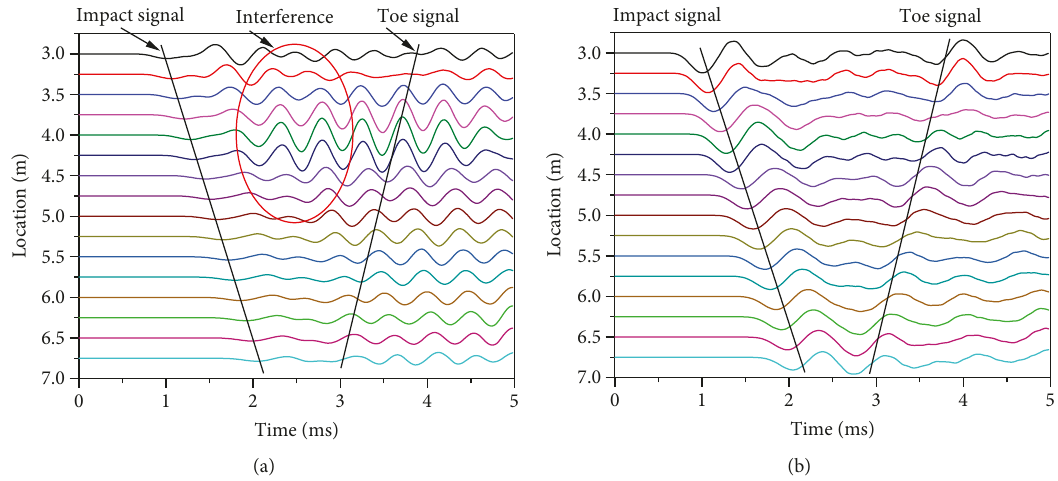
Figure 23: Raw velocity data. (a) Velocity data at A